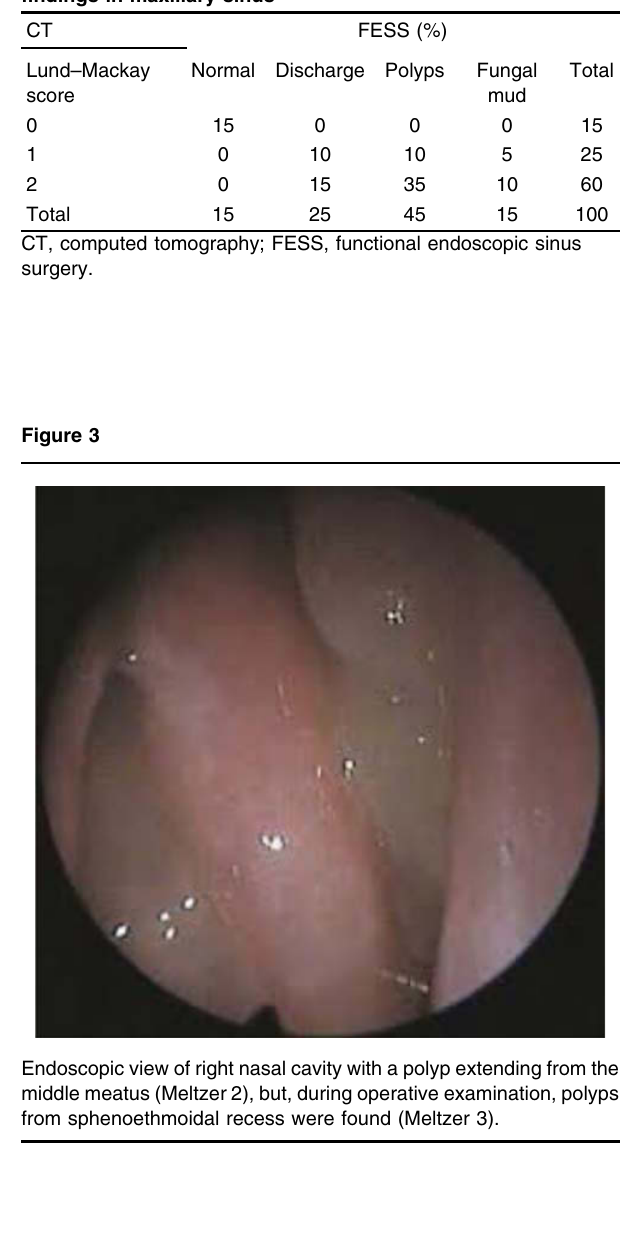
Table 3 Correlation between CT staging score and operative findings in maxillary sinus